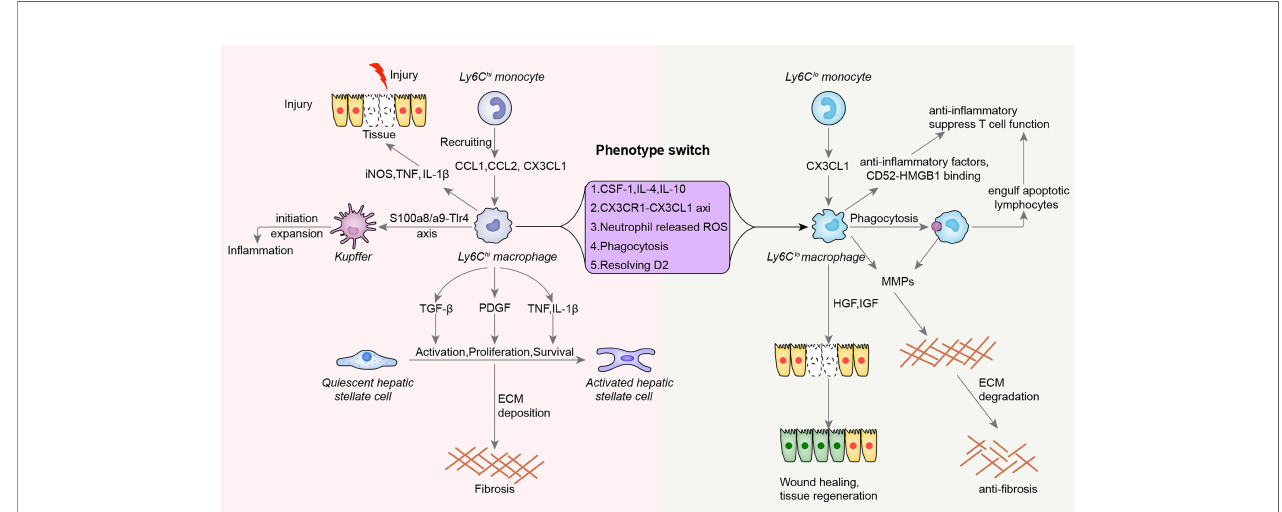
FIGURE 1 | The distinct functions of Ly6C hi and Ly6C lo macrophages in injury, chronic in fl ammation and wound repair. During the initial stage of in fl ammation, Ly6C hi monocytes are recruited to the injury site via cytokines, including CC-chemokine ligand 1 (CCL1), CC-chemokine ligand 2 (CCL2), and fractalkine (CX3CL1), wherein they develop into Ly6C hi macrophages. These cells express proin fl ammatory mediators, such as nitric oxide (NO), tumor necrosis factor (TNF) and interleukin-1 b (IL-1 b ), which exacerbate tissue injury. These Ly6C hi cells interact with kidney-resident macrophages through the S100a8/a9-Tlr4 axis, initiating and amplifying the in fl ammatory response. During fi brosis, Ly6C hi cells promote this process through the effects of transforming growth factor- b (TGF b ) on quiescent hepatic stellate cell activation, platelet-derived growth factor (PDGF) on myo fi broblast proliferation and TNF and IL-1 b on activated hepatic stellate cells. Ly6C